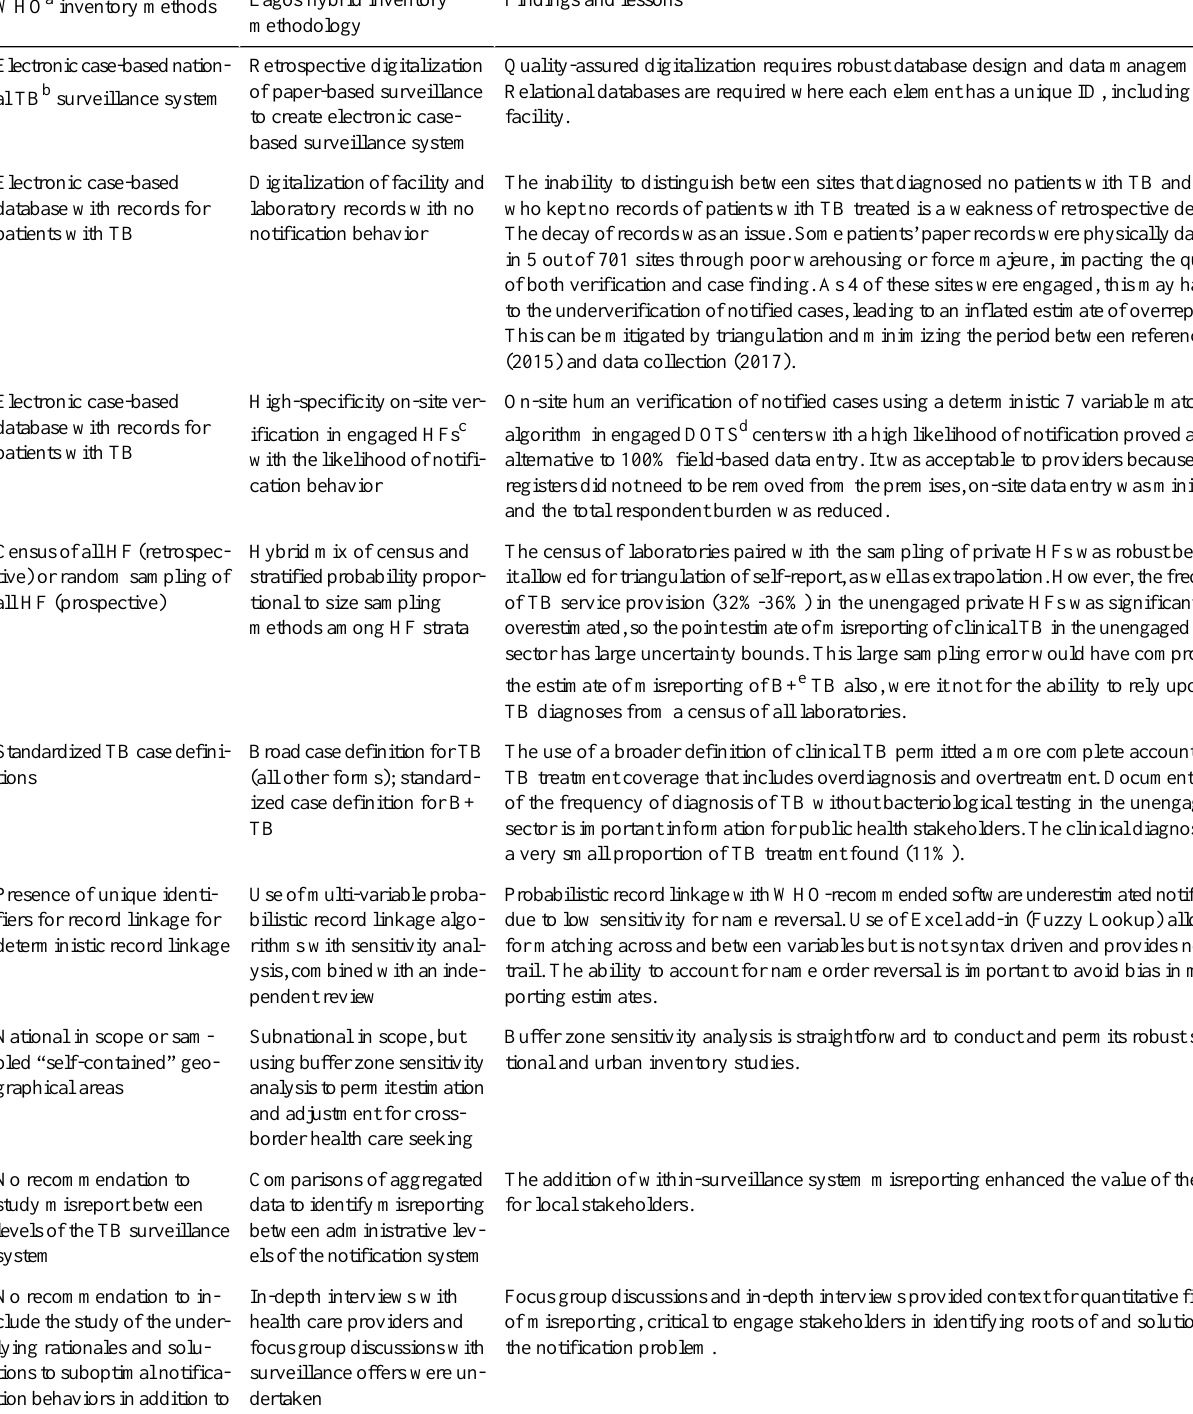
Table 2. Findings and lessons derived from the implementation of the Lagos hybrid inventory methodology.